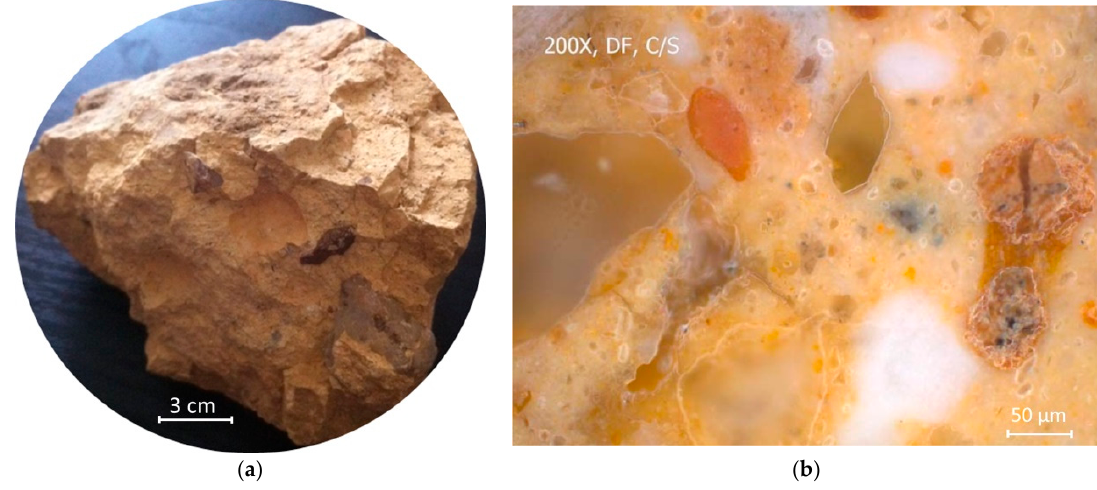
Figure 1. Original TCC sample ( a ) and its optical microscope image ( b ).